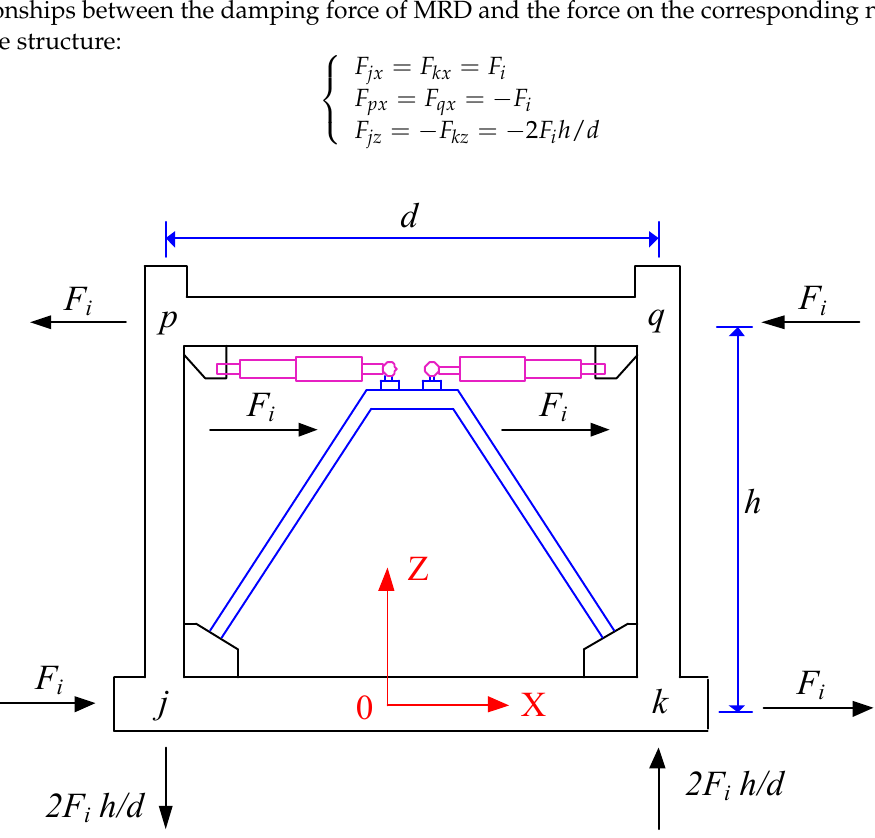
Figure 6. The schematic diagram of damping force distribution.